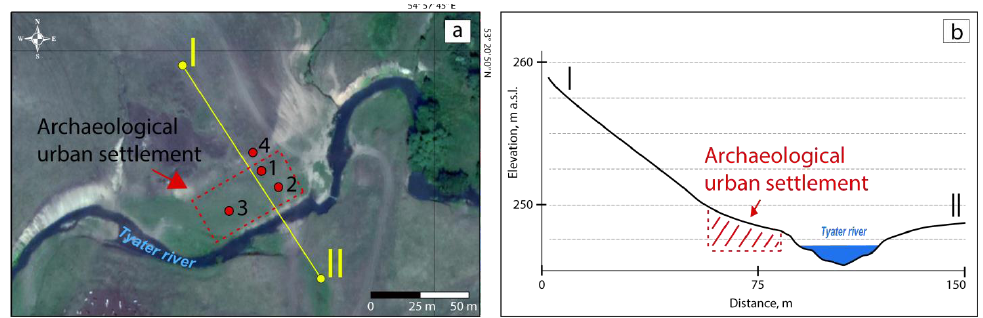
Figure 2. ( a ) Soil pit sites 1 – 4 (see also Figure 3) and ( b ) longitudinal profiles I – II at the Tyater- Araslanovo-II settlement archeological site.